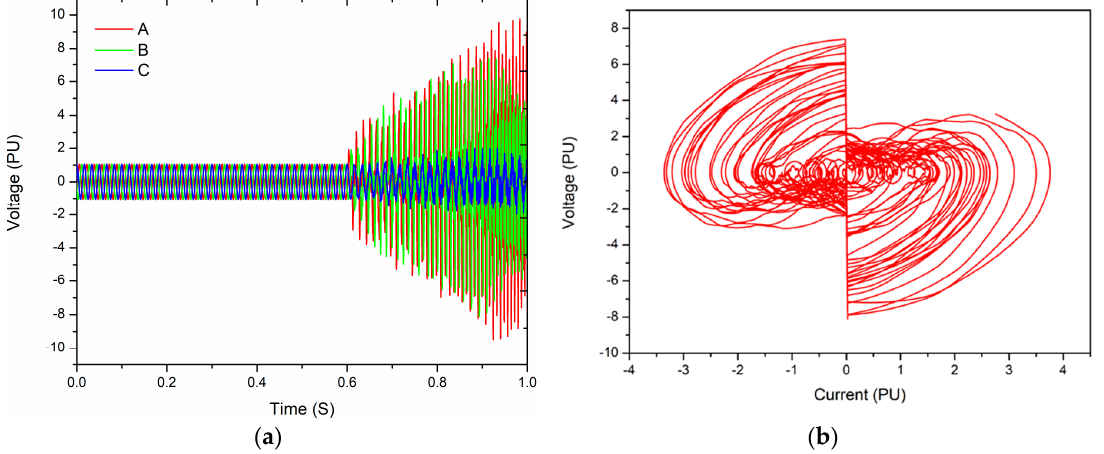
Figure 15. The ferroresonant results during de ‐ energization at 0.6 secs on the PMSG wind turbine: ( a ) Voltage waveform with highest overvoltage on phase A; ( b ) Phase plane diagram of phase B showing chaos.